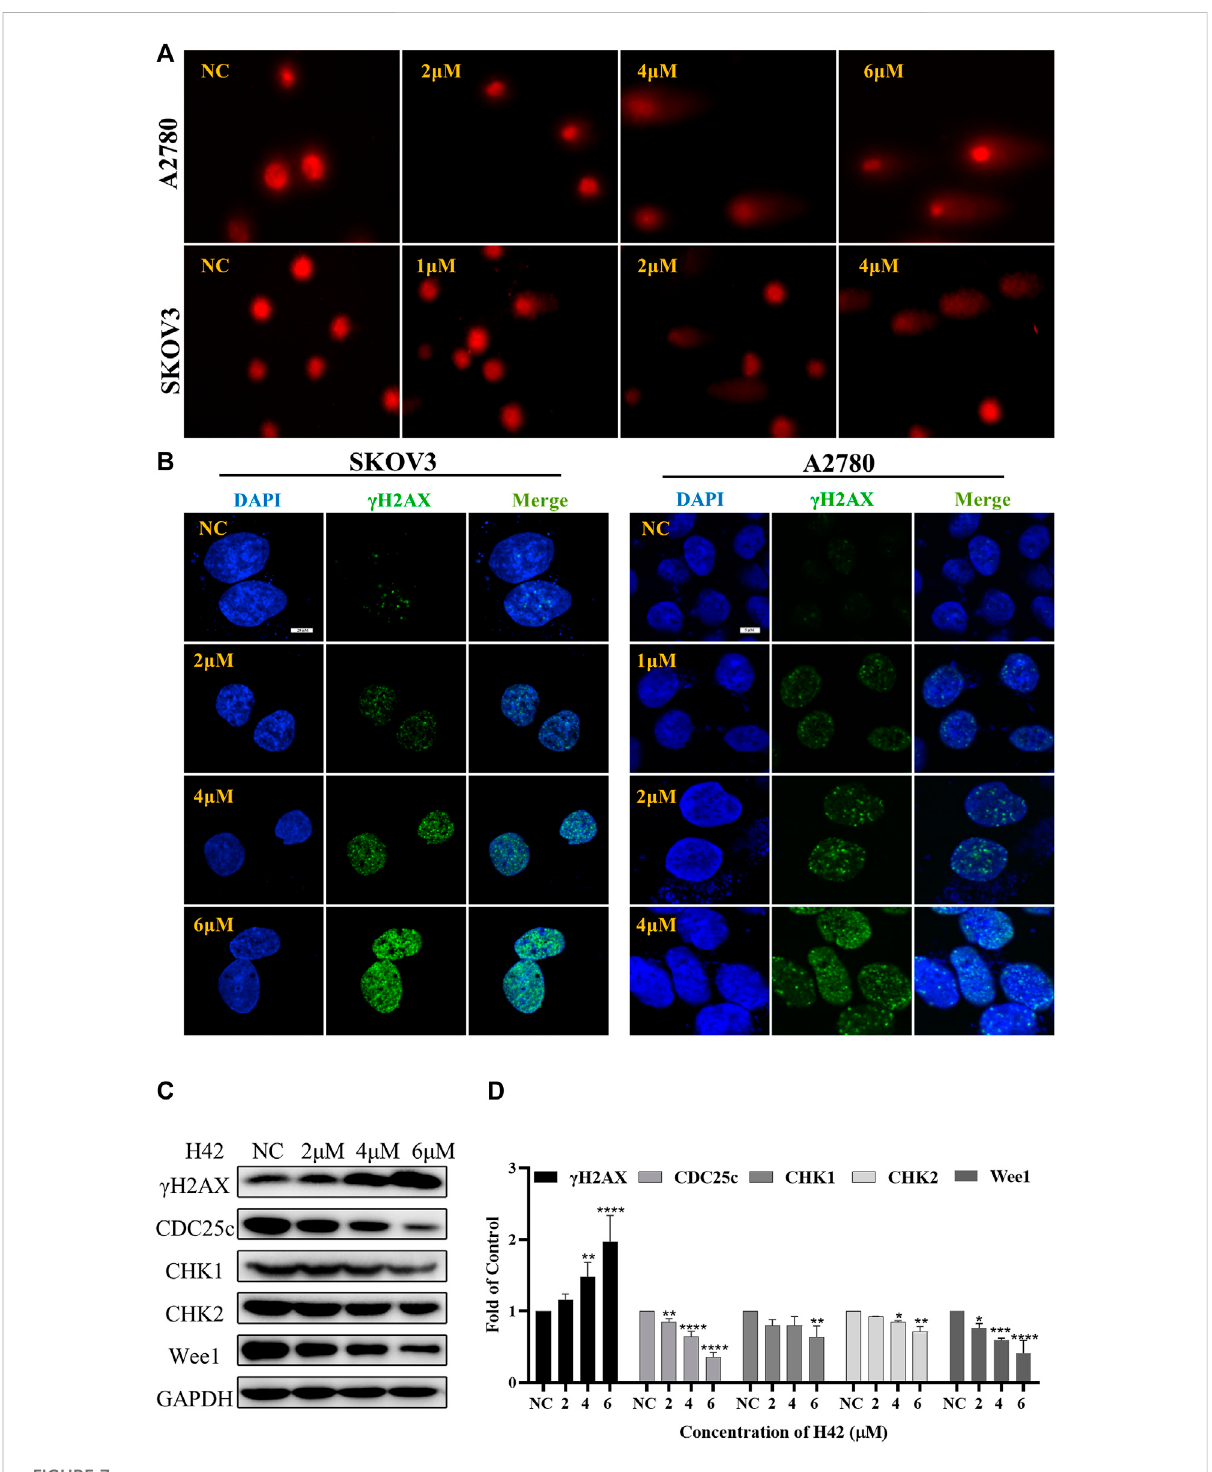
Compound H42 treatment induced DNA damage and down-regulated DNA damage response protein expression in ovarian cancer cells. A2780 and SKOV3 cells were treated with various concentrations of H42 for 48 H. (A) DNA damage was analyzed by alkaline comet assay. (B) Expressionof γ H2AXwasdetectedbyimmuno fl uorescenceusingconfocalmicroscopy. (C) ExpressionofDNAdamageresponse-relatedproteinsin A2780 cells was measured by Western blot and (D) analyzed in the density ratio. Data are all represented as mean ± SD of at least